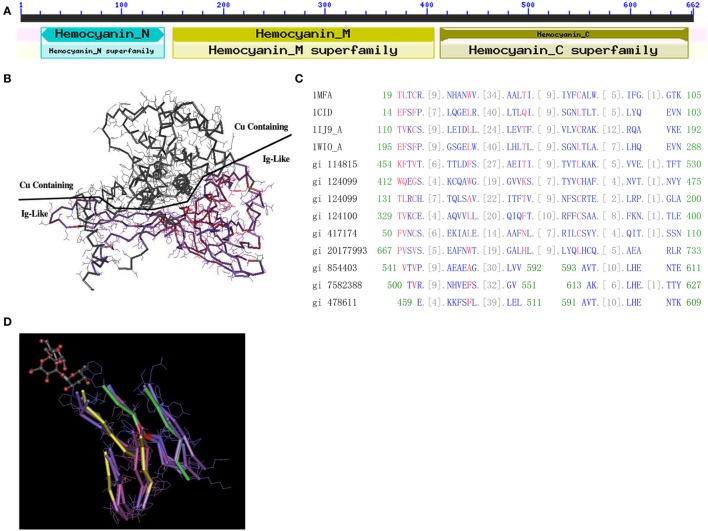
Protein structure of hemocyanin (HMC). (A) The conserved domains of L. vannamei S-HMC (X82502.1/gi|854403). The domain is divided into D1 (HMC N, length 20–148, all-alpha conserved domain), D2 (HMC M, length 150–407, copper containing domain), and D3 (length 413–657, Ig-like conserved domain). (B) The three-dimensional structure of S-HMC, indicating that D2 and D3 are exposed on each side of the S-HMC structure, with both having an equal chance of exposure to the environment. (C) Conserved domain alignment of the Ig domain (cd00096) with HMC D3 of gi|854403, gi|7582388, and gi|478611 from shrimp. (D) A tertiary structure of an Ig skeletal domain, showing a skeleton structure with five beta-folding units which are made up of several overlapping Ig domains (NCBI Conserved Domains id: Cd00096). Out of the five folding units, amino acid residues 541–592 and 593–611 of S-HMC D3, are matched on three of the five beta-folding units (marked yellow) and on the other two (marked green).